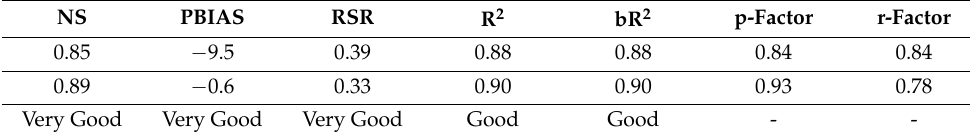
Table 3. Calibration